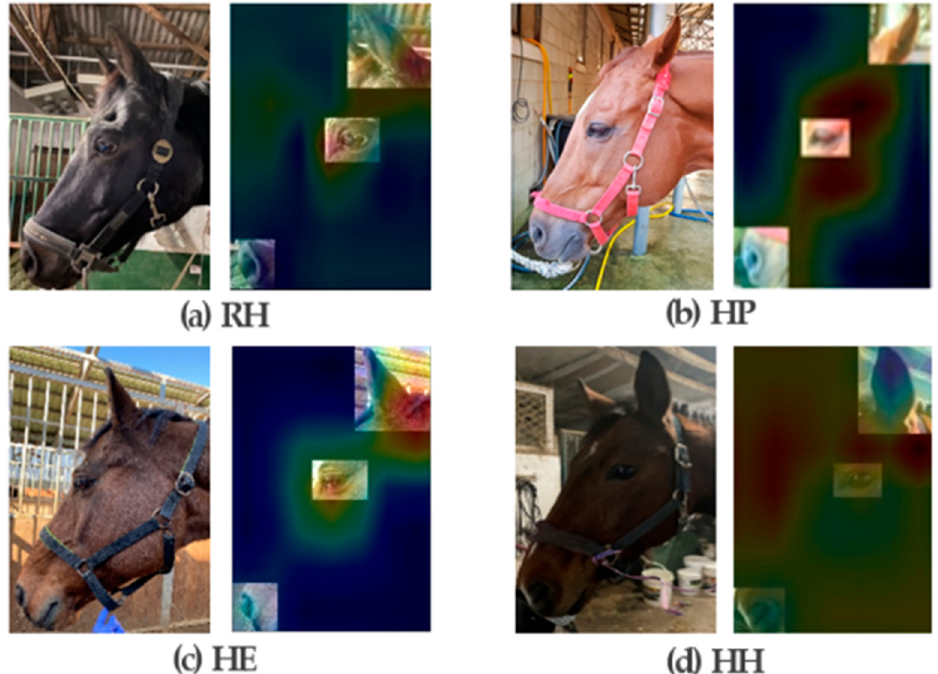
Figure 6. The maps highlight the discriminative image regions used for image classification. A simple modification of the global average pooling layer combined with our class activation mapping (CAM) technique allows the classification-trained CNN to both classify the image and localize class-specific image regions in a single forward pass: ( a ) RH; resting horses, ( b ) HP; horses with pain, ( c ) HE; horses immediately after exercise, and ( d ) HH; horseshoeing horses.